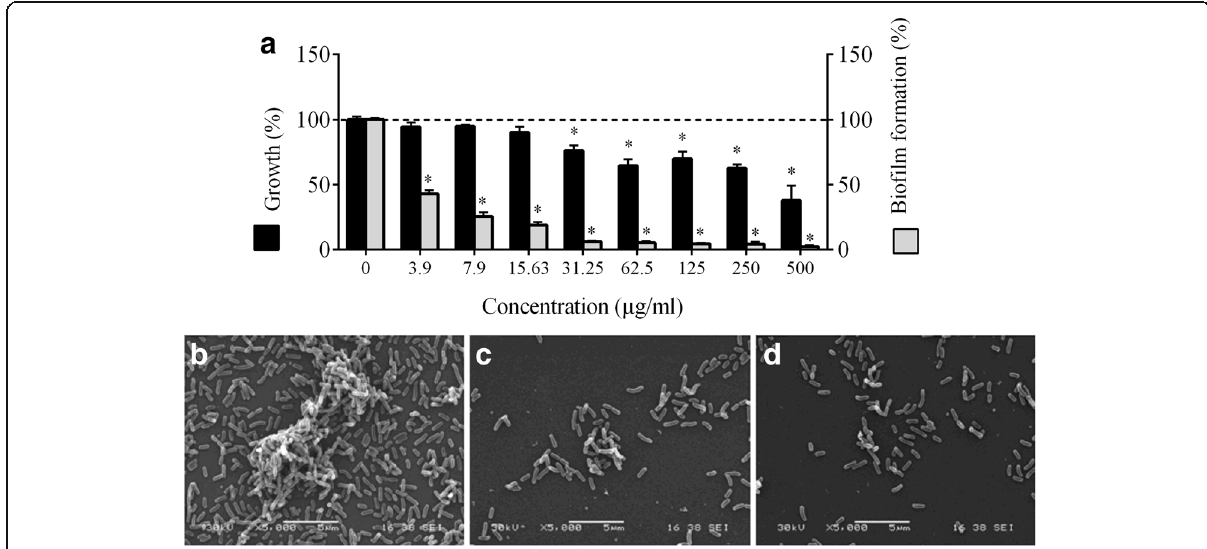
Fig. 1 Effect of highbush blueberry PACs on A. actinomycetemcomitans growth and biofilm formation (panel a ). ∗ : significantly different ( p <0.01) from the control (no PACs). Scanning electron micrographs of A. actinomycetemcomitans biofilms formed in the absence (panel b ) and presence of 31.25 μ g/ml (panel c ) and 62.5 μ g/ml of highbush blueberry PACs (panel d